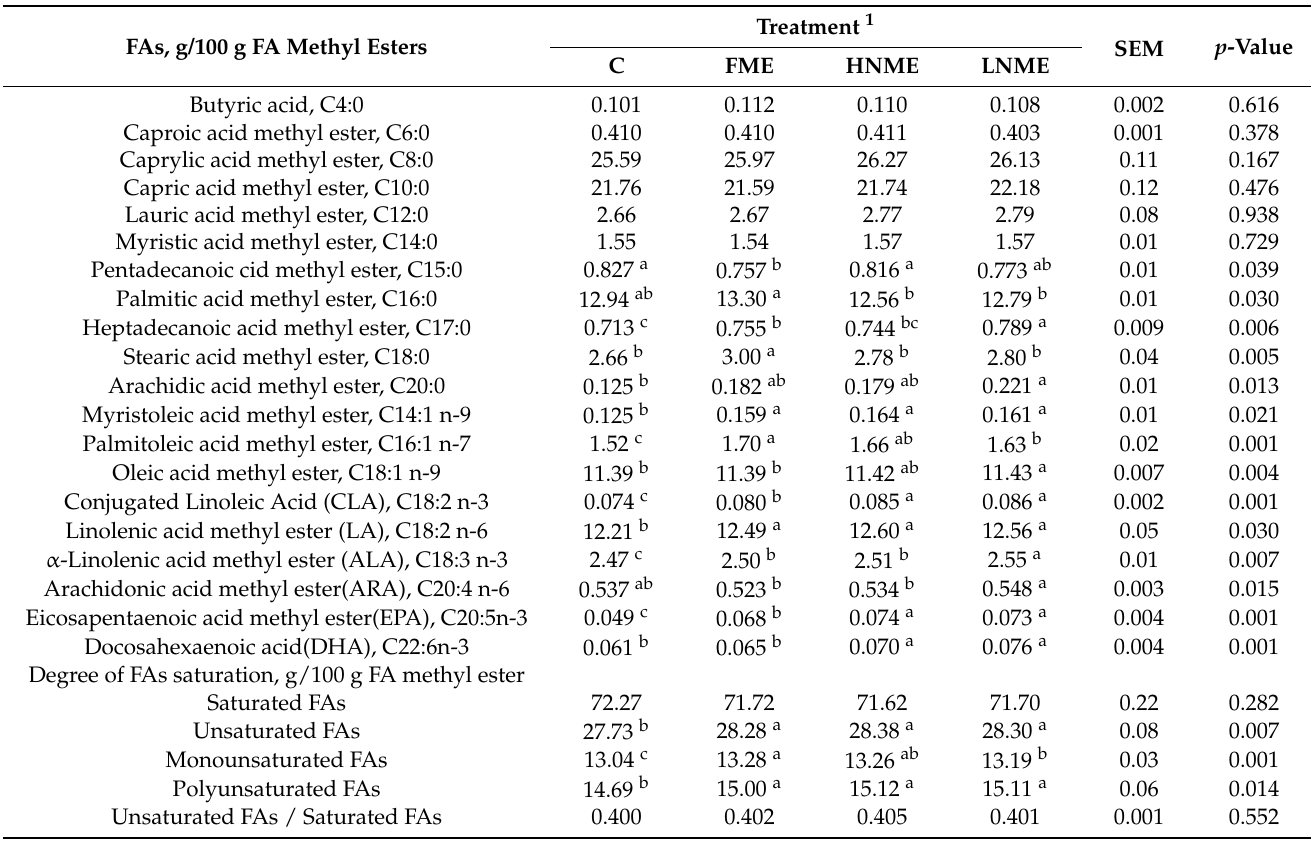
Table 4. Effects of free and nano-encapsulated Moringa oleifera leaf ethanolic extract (ME) supplemen- tations on milk fatty acids (FAs) profile of multiparous rabbit does during the experimental period (mean ± SEM).